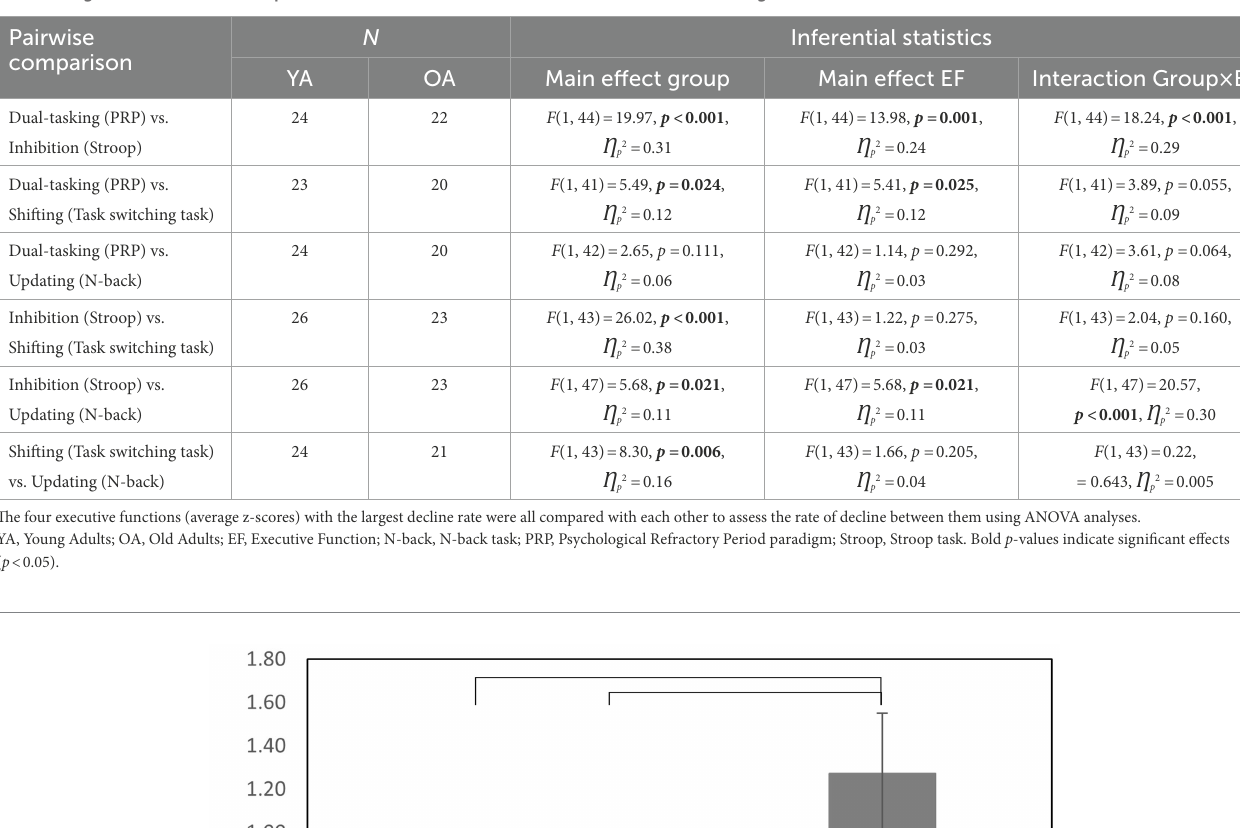
TABLE 4 Age-related decline comparison between the four executive function abilities amongst the older adults.